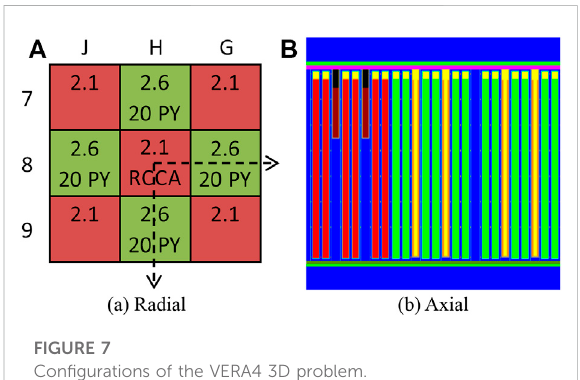
can used reduce